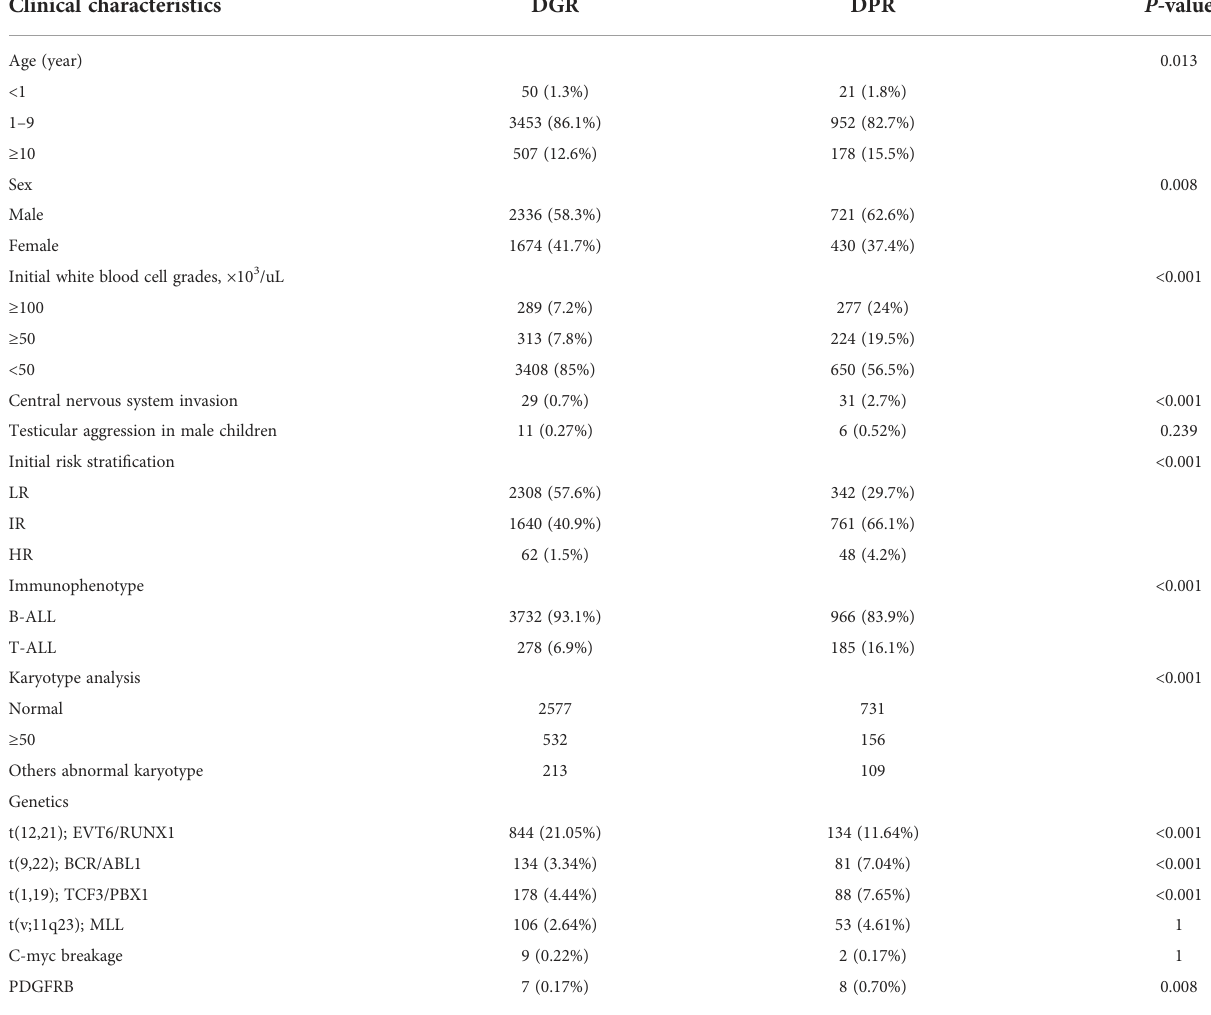
TABLE 1 Biological features of children with acute lymphoblastic leukemia according to dexamethasone response. Clinical